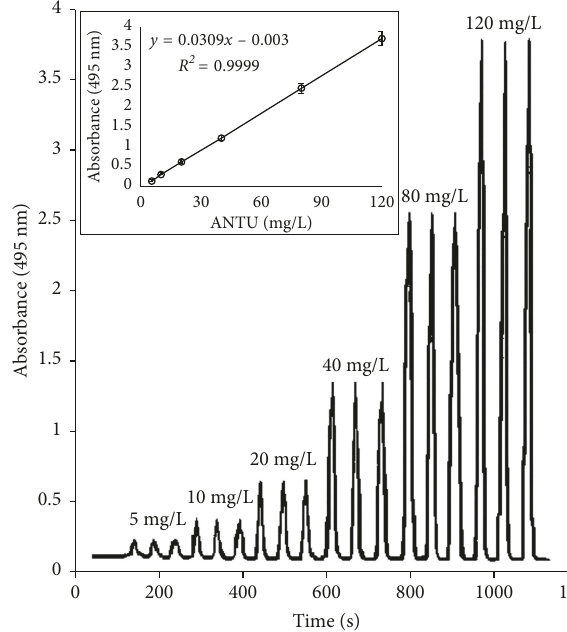
Figure 4: Traces of absorbance peak height for a series of ANTU standards injected in triplicate (inset shows the calibration curve).